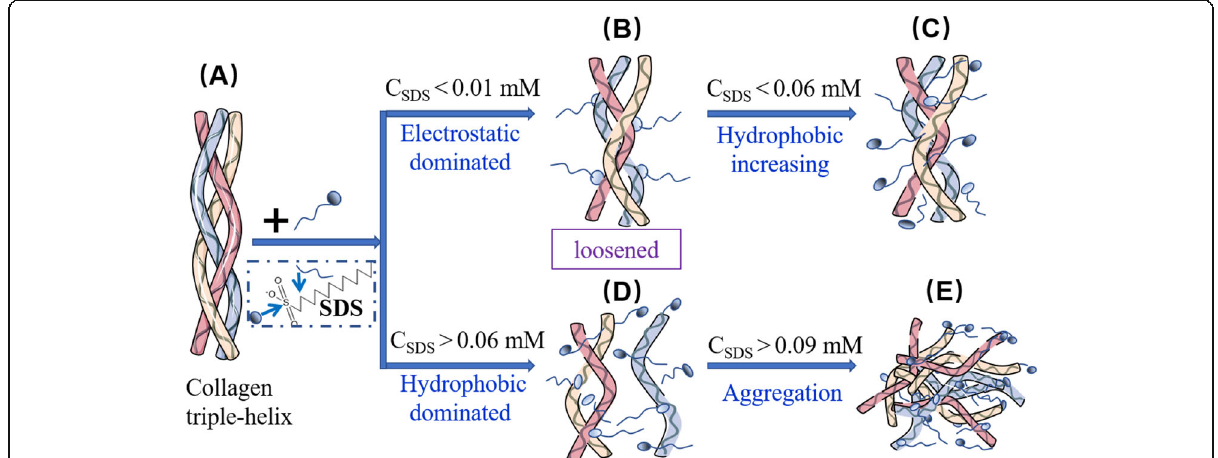
Fig. 2 Schematic of interactions between collagen molecules and anionic surfactant sulfate dodecyl sodium (SDS): ( A ) native triple-helix of collagen; ( B ) and ( C ): loosened structure of collagen molecule; ( D ) and ( E ): unfolding of collagen